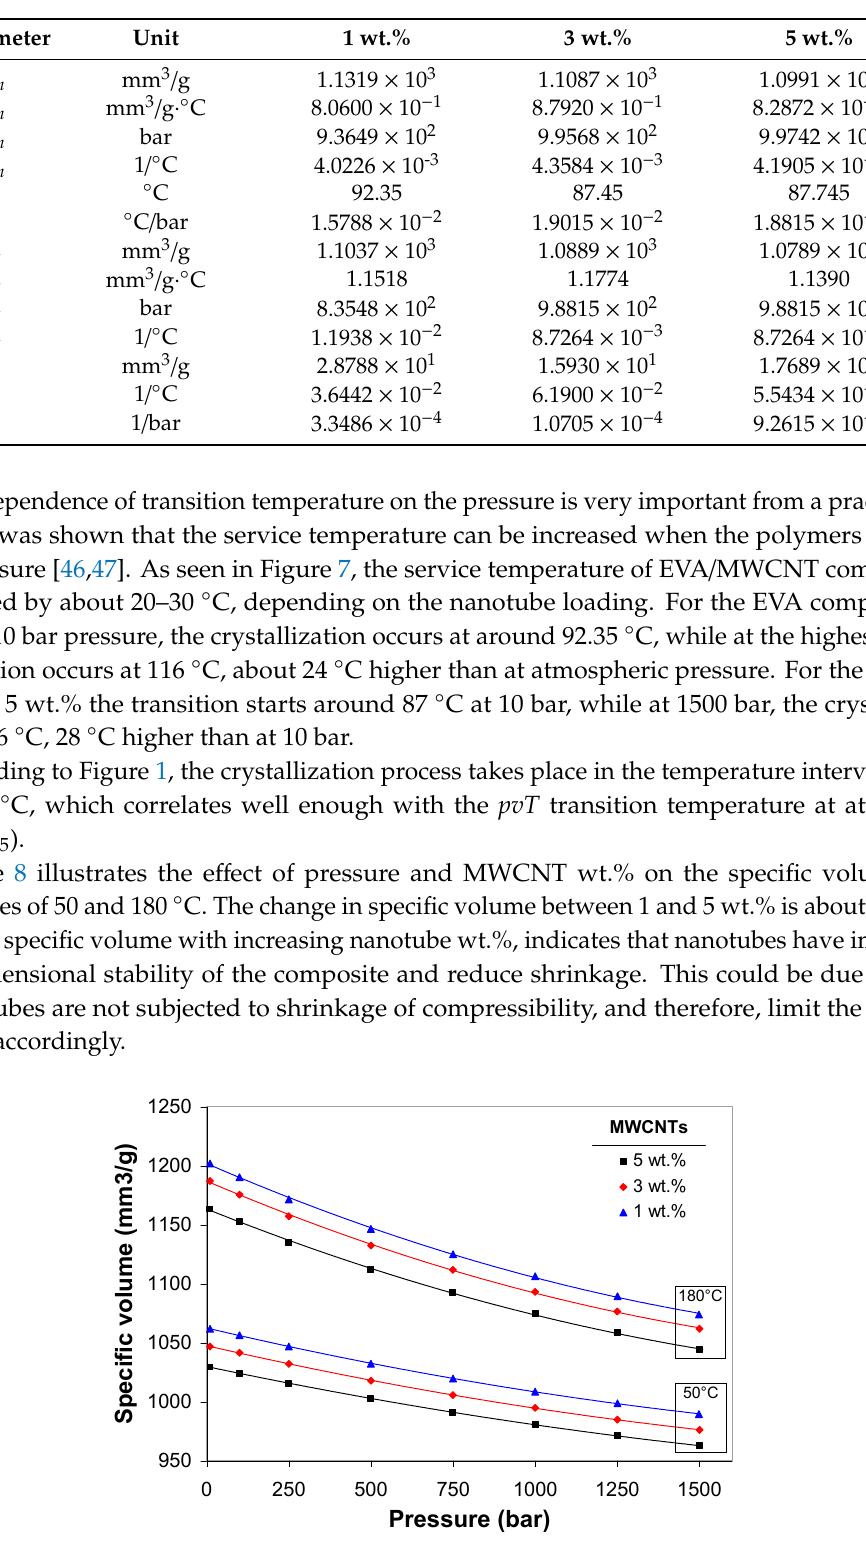
Table 3. Tait parameters for EVA / MWCNT composite.